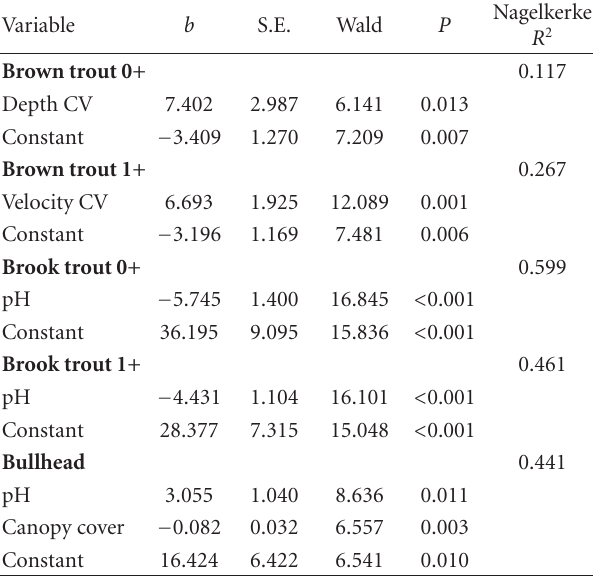
Table 5: Results of logistic regression with forward selection for the occurrence of brown trout, brook trout, and bullhead in relation to environmental factors in 1994. Separate analyses were performed for 0+ and 1+ trout.